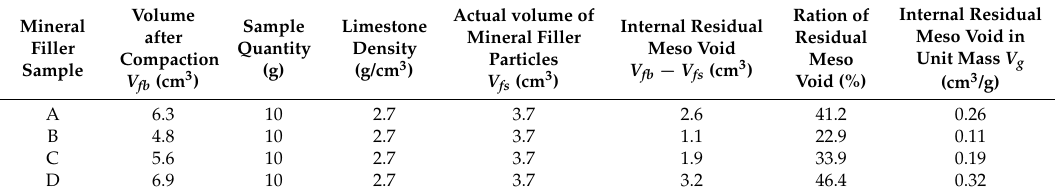
Table 3. Test Results on the Meso Void of the Four Kinds of Mineral Filler in Unit